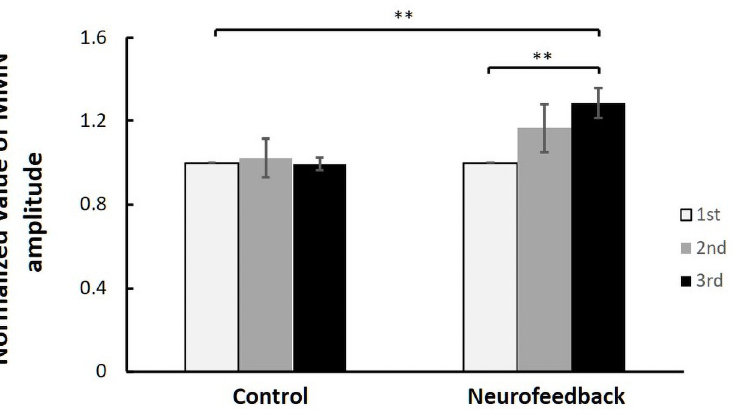
Fig 6. Effect of NF training on changes in neural activity. Absolute values of average MMN amplitudes for all participants on the first and third training day in the NF group and control group. Error bars for the data are SEM; �� p <